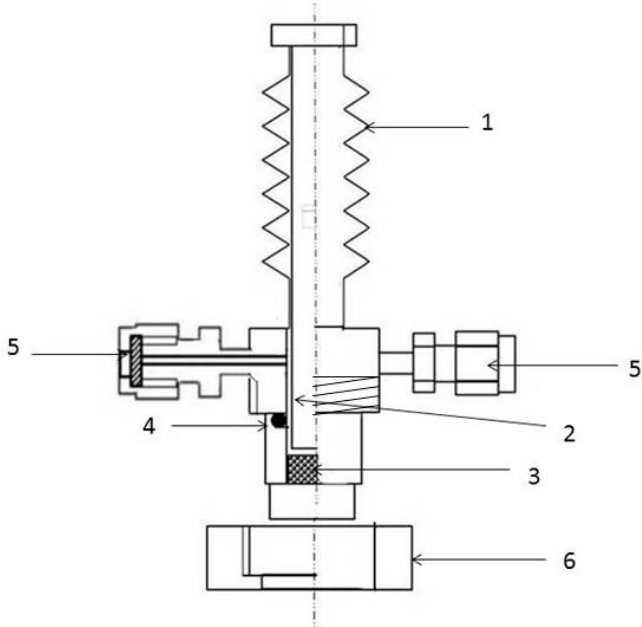
Figure 1. Sketched hammer mill. Below (1), the mill has an inner diameter of 8 mm. There is a mill hammer (2) inside. A sample of the rock (3) is placed in the lower part of the mill, sealed with an O-ring (4). The tubes (inner diameter: 1 / 16 inch) end with Swagelok tube fittings with septa (5). The mill is complete with a sealing nut (6).